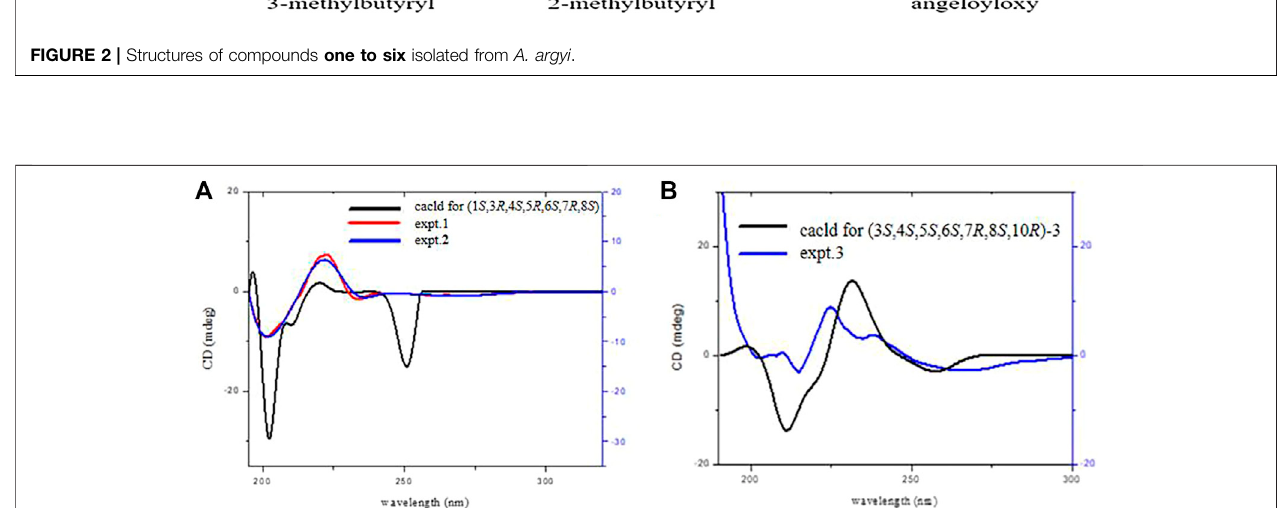
FIGURE 3 | ECD spectra of compounds 1 , 2 (A) , and 3 (B) (data calculated using the TDDFT method at the B3LYP/6 – 31 + g(d, p ) level.).